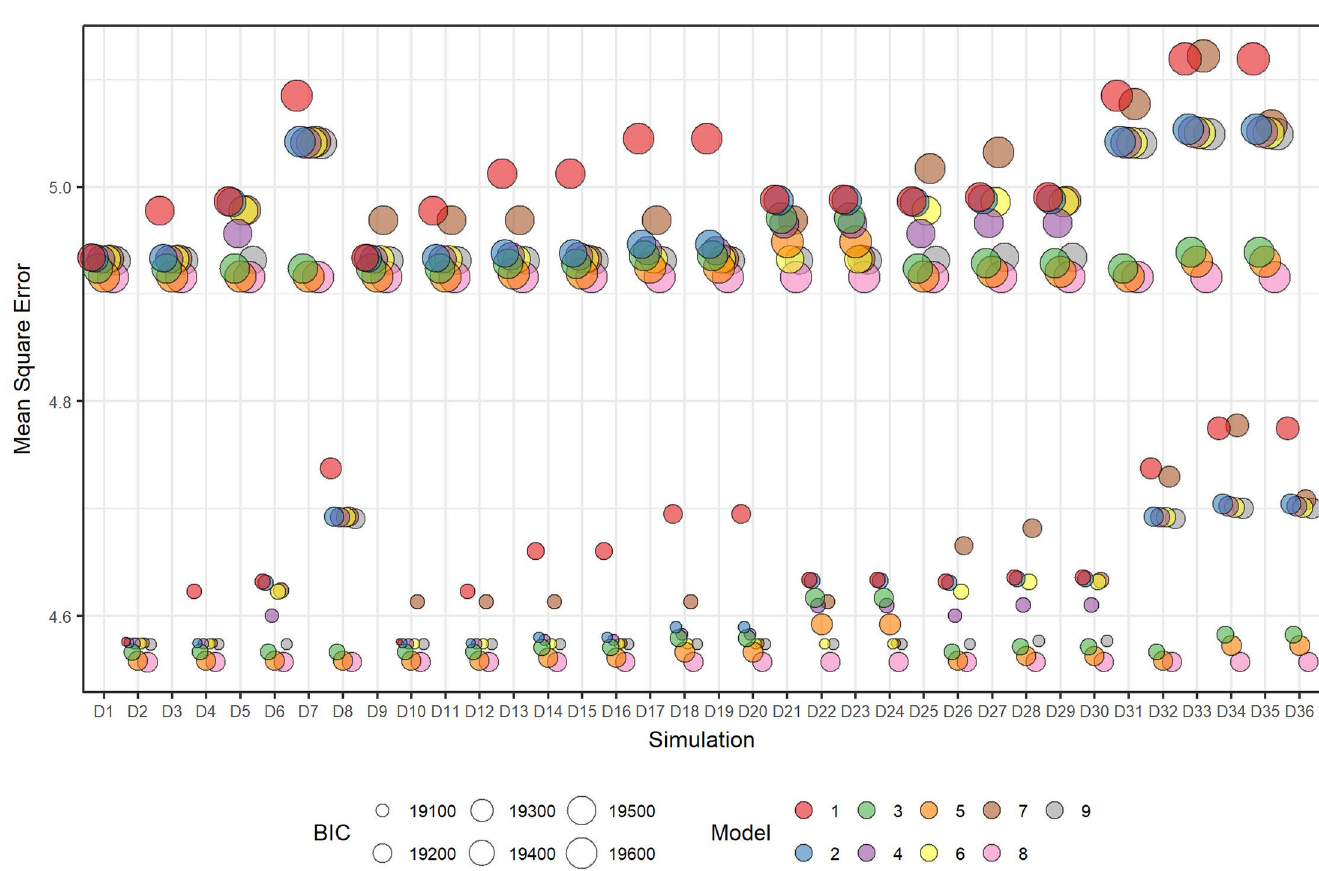
Fig 8. Plot of the mean of the MSE (mean square error) and mean BIC over all datasets within each scenario for each fitted model and where fitted models have assumed CS correlation structure.